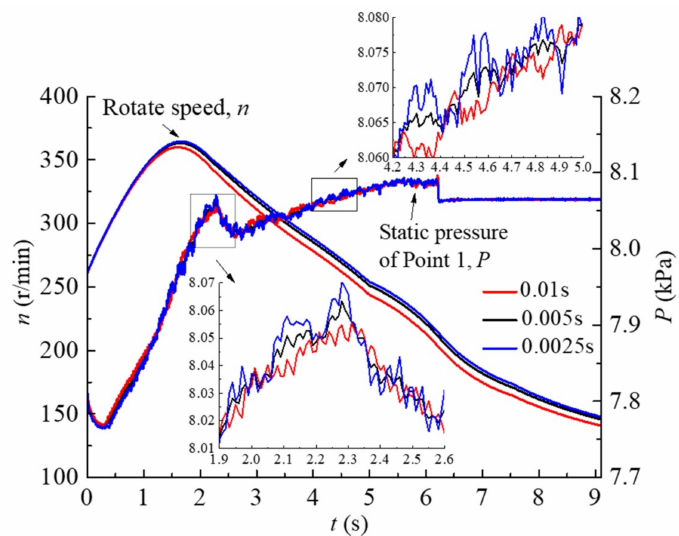
Figure 7. Pre-calculated results of different time step